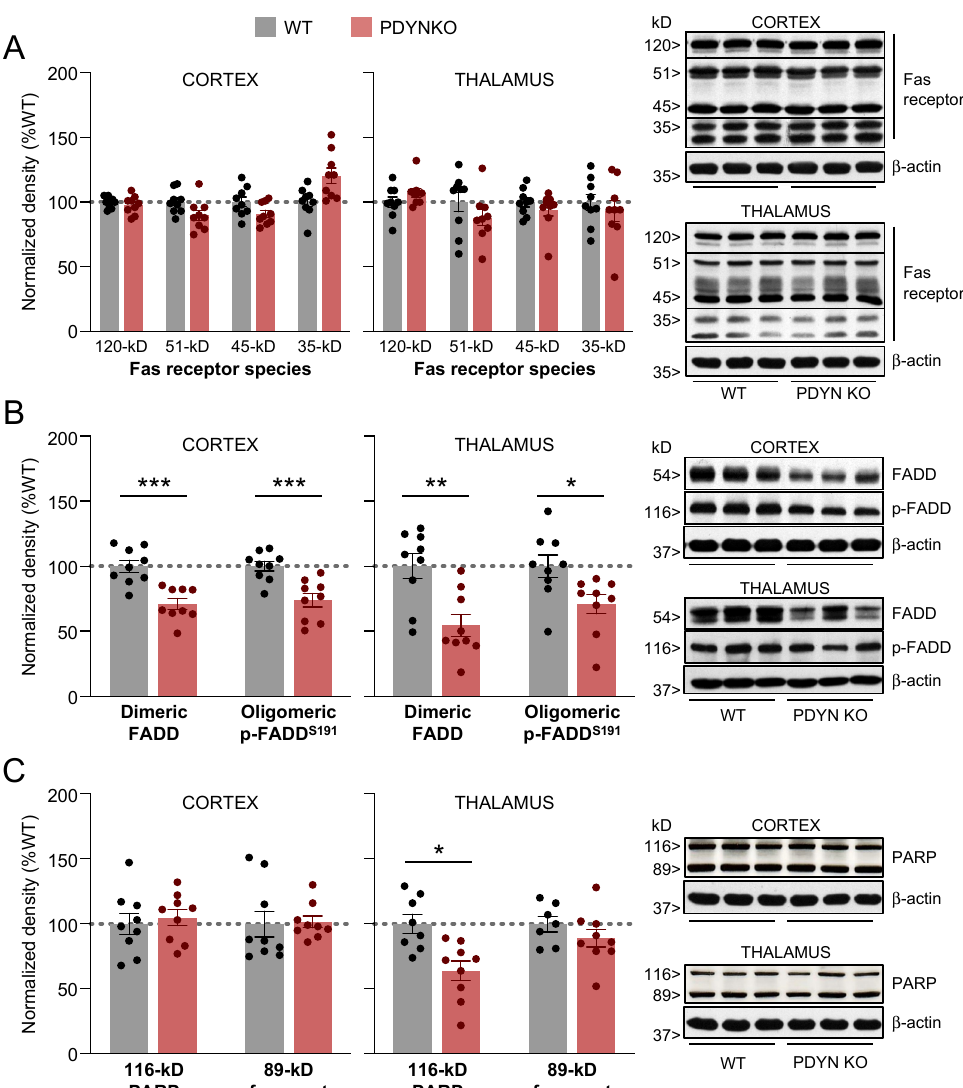
Figure 2. Immunodensities of ( A ) Fas receptor forms, ( B ) dimeric and oligomeric p-Ser191 FADD species, and ( C ) full-length (116-kDa) and cleaved (89-kDa) PARP in cortical and thalamic brain tissue samples from WT (grey bars; n = 9) and PDYN-KO (reddish bars; n = 9) mice. Normalized protein amounts were estimated as the ratio between each immunoreactive band to β -actin. Columns are means ± SEM of each experimental group and expressed in percent change from WT animals for each brain region. * p < 0.05, ** p < 0.01, and *** p < 0.001, Student’s t test. ( A – C ) Representative immunoblots of cortical and thalamic Fas, FADD, and PARP species (three different animals per group) are shown on the right. The indicated molecular weights (in kDaltons, kDa) of the immunoreactive bands were estimated from in-gel-loaded, prestained protein standards.